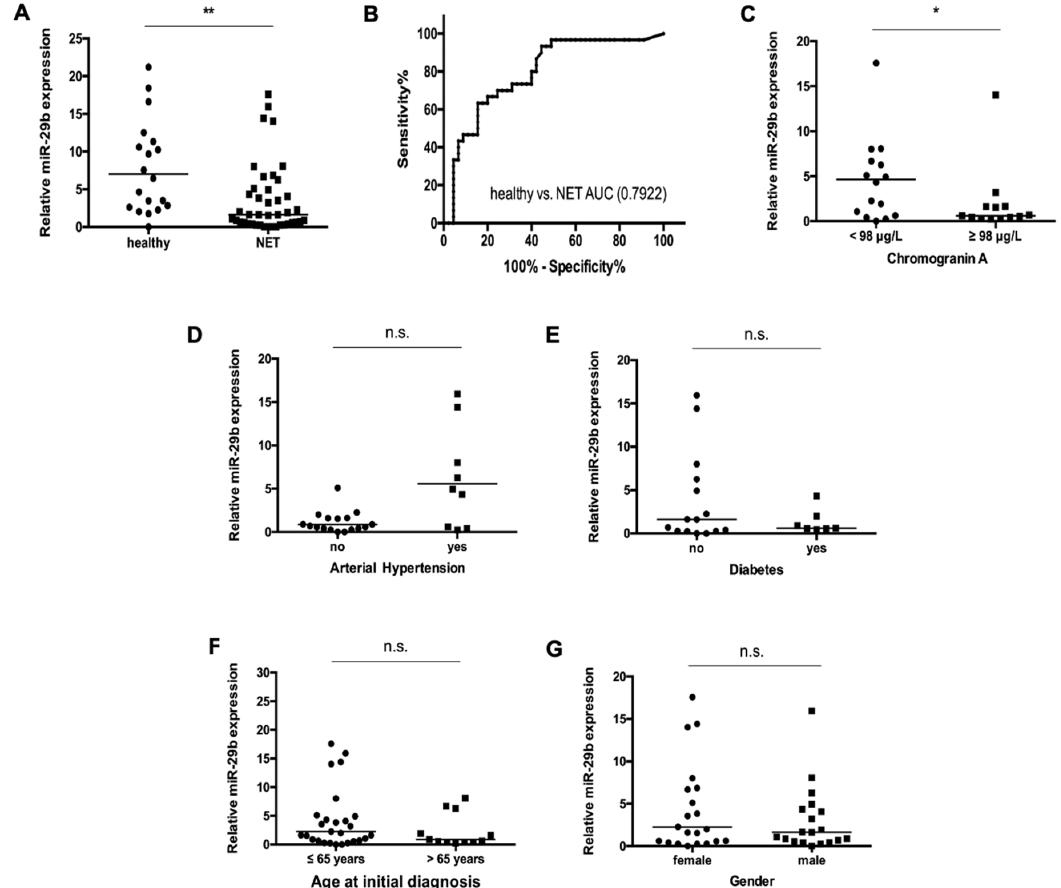
Figure 1. miR-29b levels are decreased in patients with neuroendocrine tumors (NET). ( A ) qPCR was used to determine relative concentrations of circulating miR-29b in patients with NET as well as in healthy controls. ( B ) Relative miR-29b levels display an AUC value of 0.7922 regarding the discrimination of NET patients and healthy controls. ( C ) Relative miR-29b concentrations were lower in patients with higher levels in chromogranin A (above the median value (98 µ g / L)) when compared to those with lower levels (below the median value (98 µ g / L)). Relative miR-29b concentrations in serum were similar in patients ( D ) with or without arterial hypertension ( E ), with or without type 2 diabetes, and ( F ) patients younger / older than 65 years, and ( G ) did not vary with respect to patients’ gender. The scatter plots display relative miR-29 expression levels between the two subgroups. The black horizontal lines represent the median per group. (* p < 0.05; ** p < 0.01; *** p <